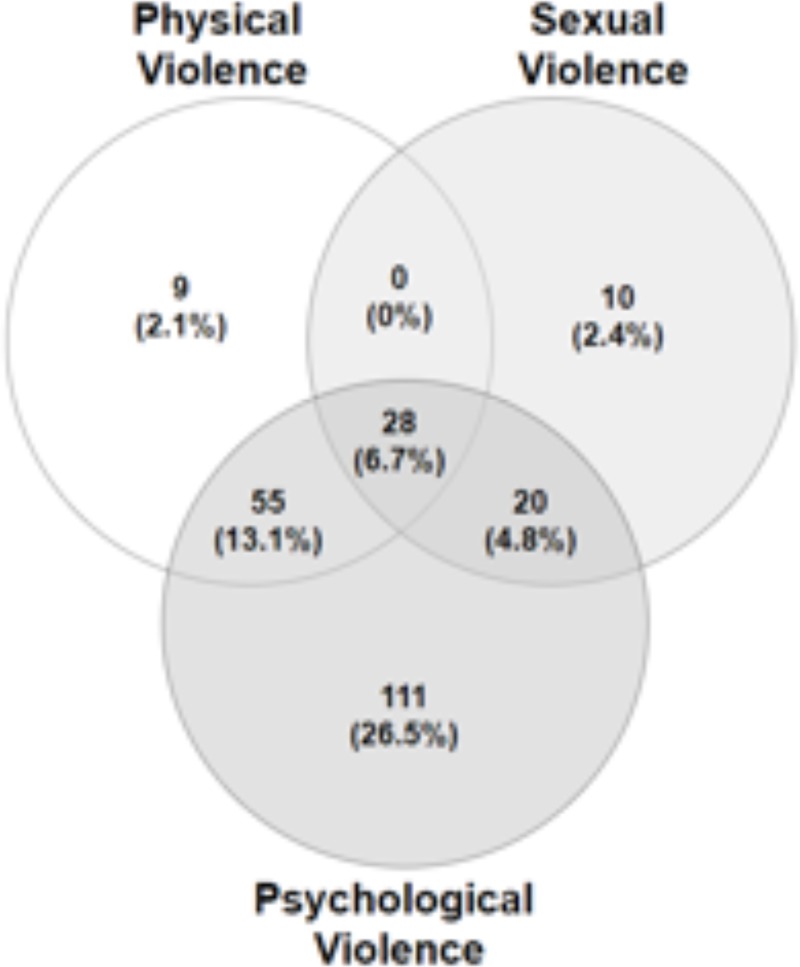
Prevalence of combinations of cases of lifetime psychological, physical and sexual violence.